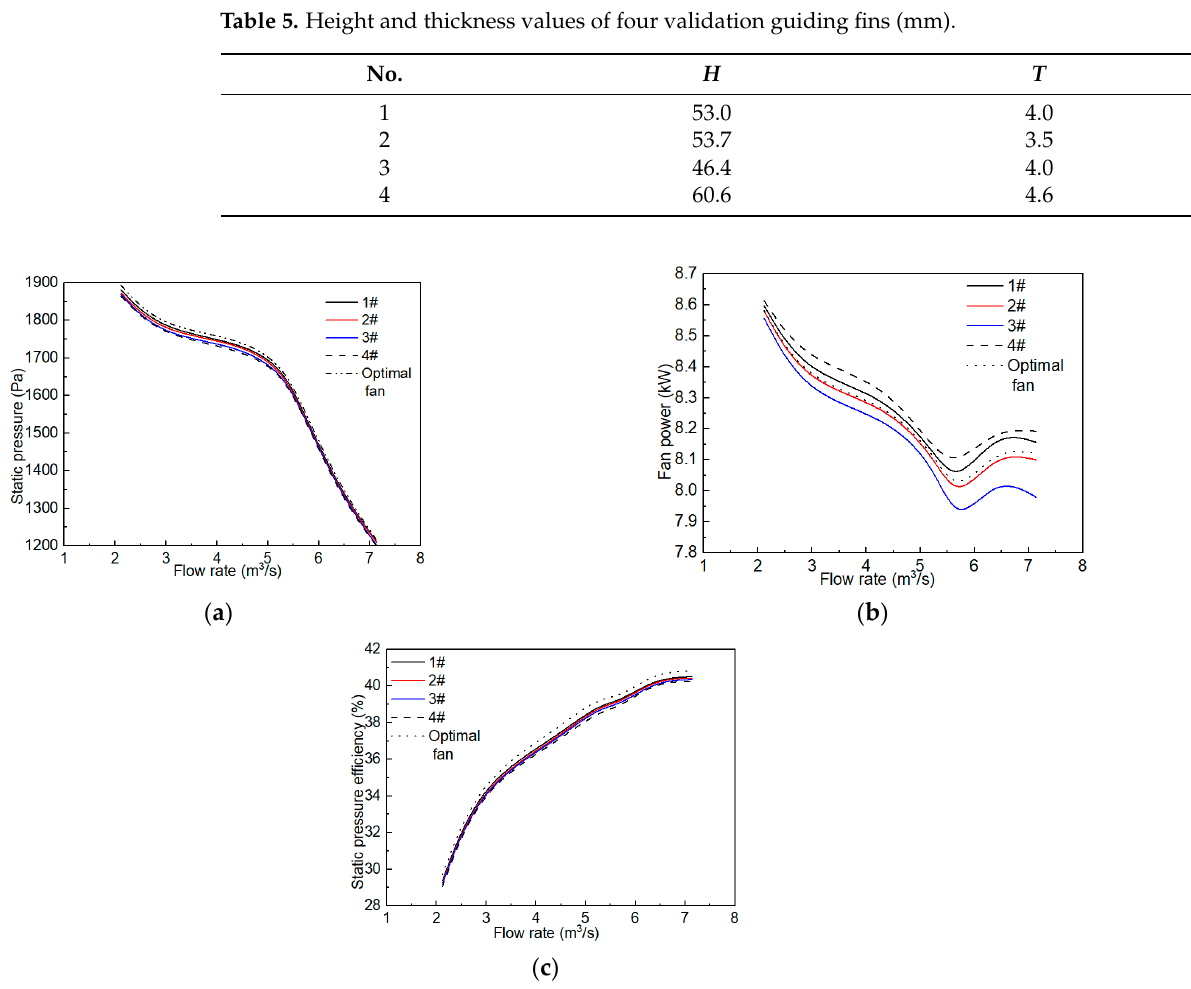
Figure 11. Simulation veri fi cation of pneumatic performances: ( a ) static pressure; ( b ) power loss; ( c ) static pressure e ffi ciency.